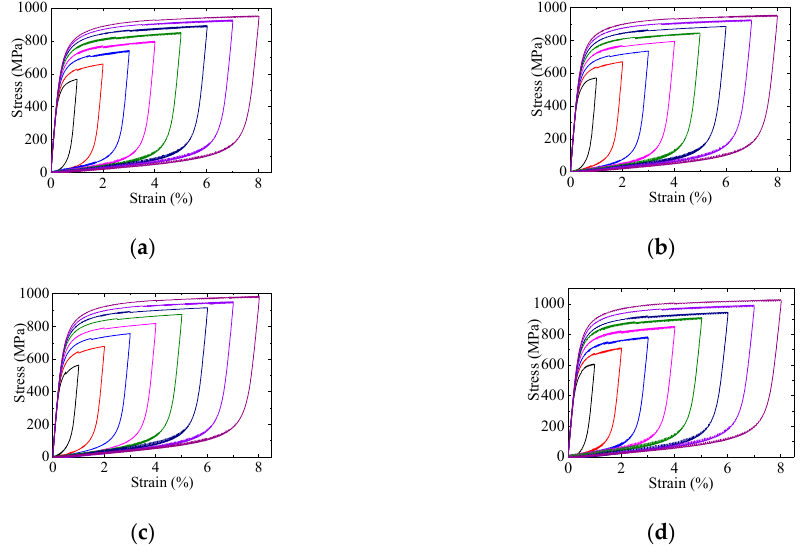
Figure 15. Relative hysteretic curves of Q235. ( a ) S ‐ NT; ( b ) S ‐ 900 ‐ 1; ( c ) S ‐ 900 ‐ 2; ( d ) S ‐ 900 ‐ 3.